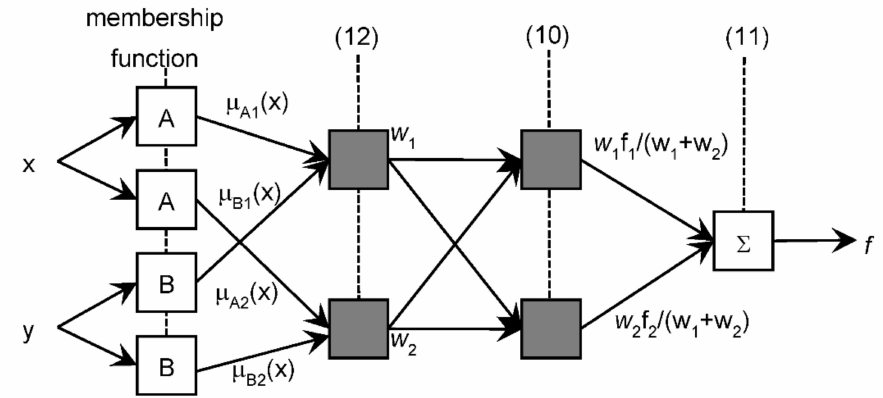
Figure 6. Procedure of ANFIS neuro-fuzzy